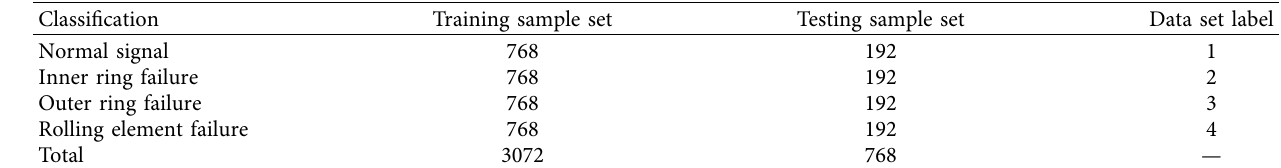
Figure 11: Schematic of bearing test device. Table 2: Different fault samples and label